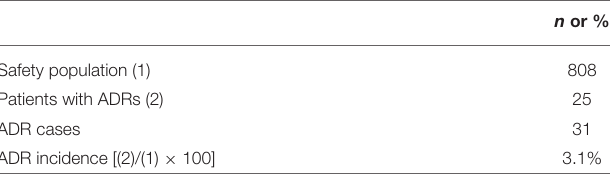
TABLE 5A | Incidence of adverse drug reactions (ADRs)*.